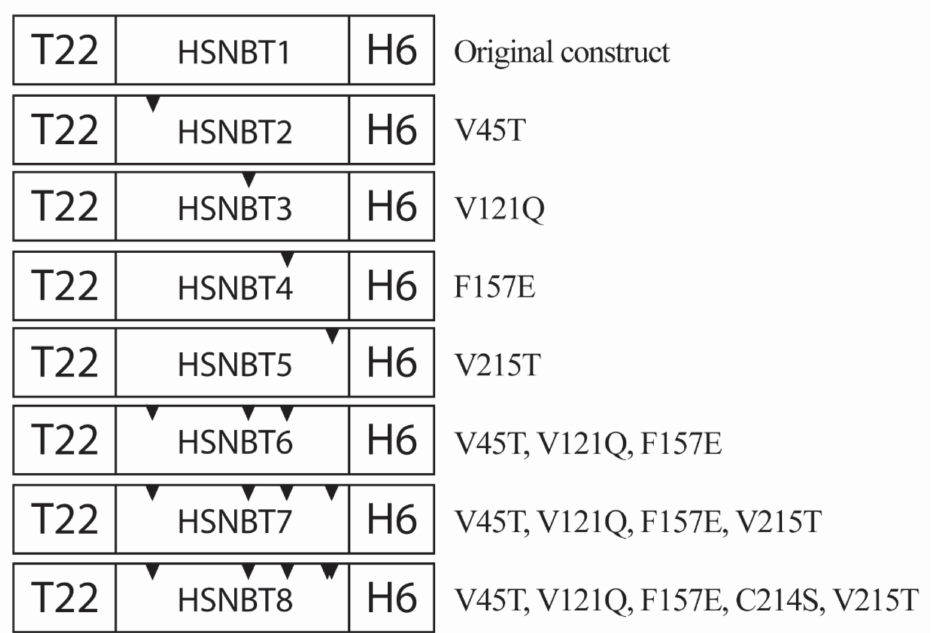
and DeepDDG (dark gray) predictors for each possible substitution in the four selected residues. Hy- drophobic residues are filled in a diagonal hatch pattern, and arrows indicate the chosen substitution for each amino acid. ( E ) Three-dimensional representation of T22-HSNBT1-H6, with the atoms of the selected residues for mutation displayed in blue. ( F ) Surface lipophilicity potential map. Insets on the right side highlight the predicted lipophilicity of the selected residues before and after substitution.